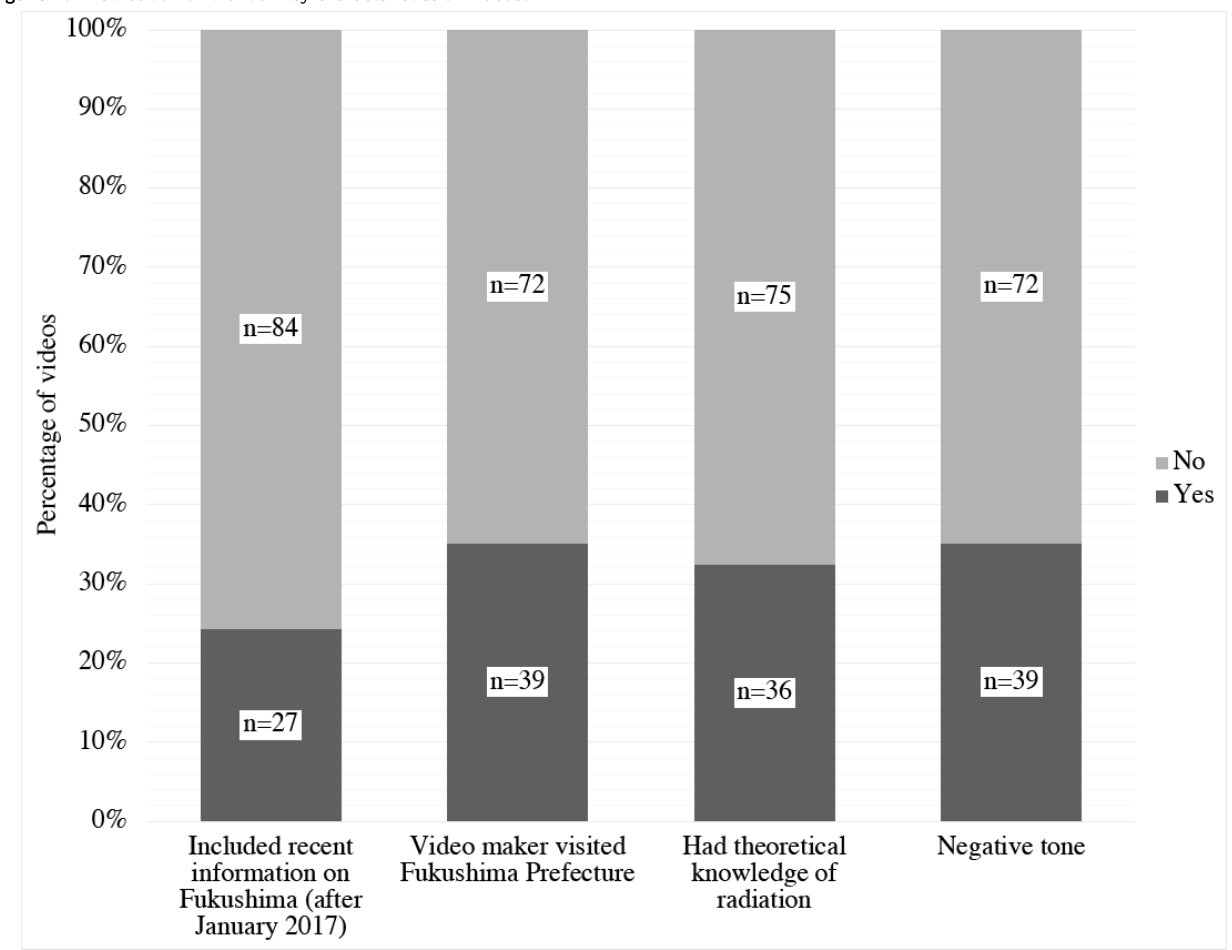
Figure 2. Distribution of the four key characteristics of